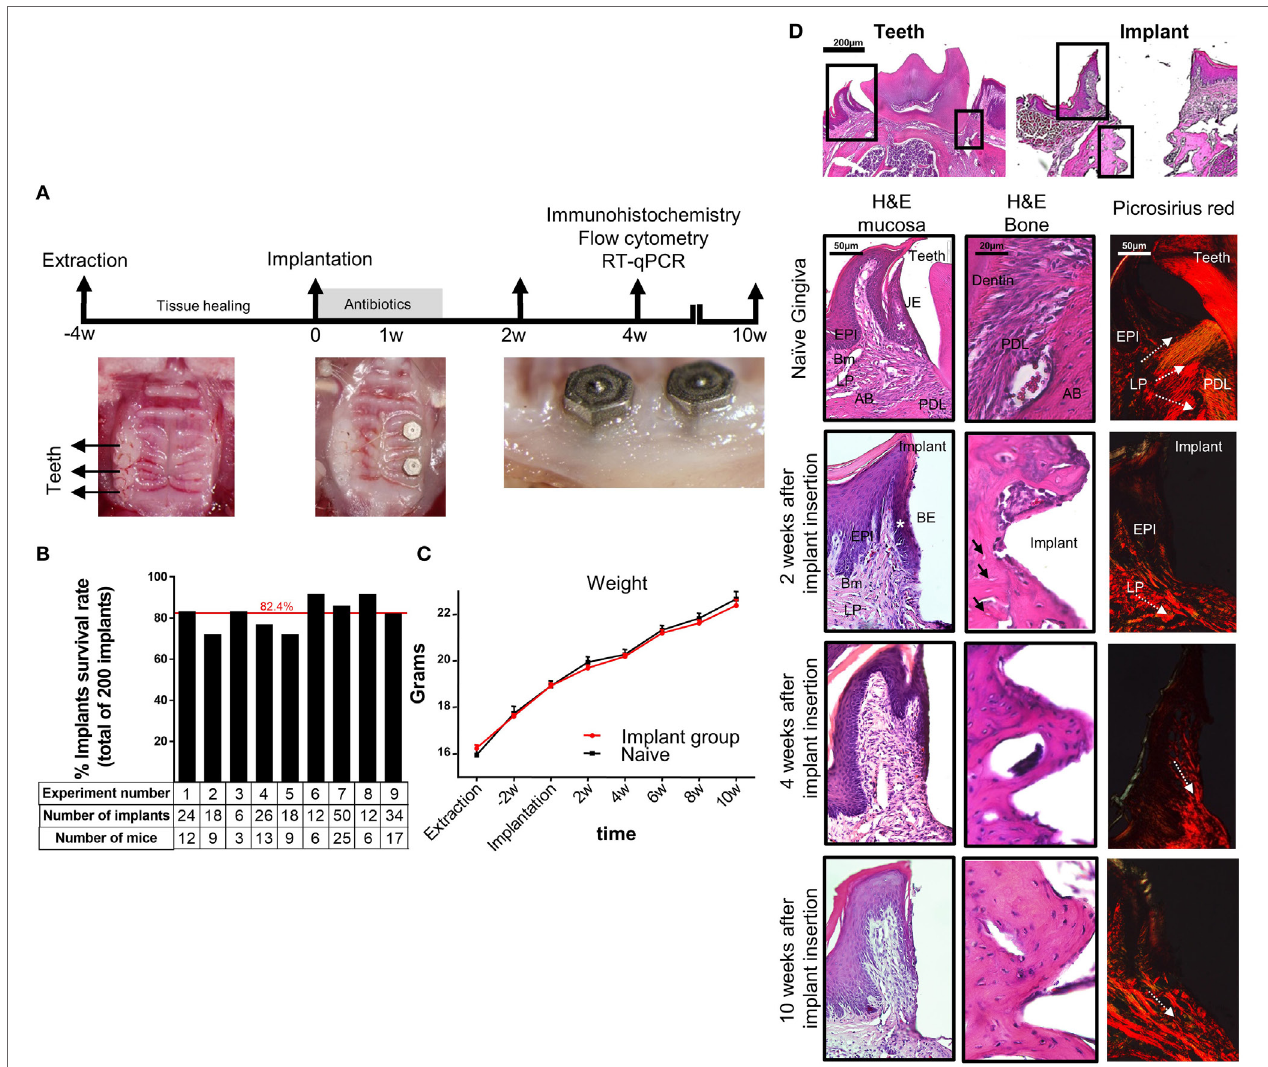
FigUre 1 | Establishment of a murine model of titanium dental implants. (a) Schematic presentation of the experimental setting for insertion of titanium dental implant. Four weeks after tooth extraction two dental implants were inserted in the first and second molar regions of the alveolar bone. The mice were treated for 1 week with antibiotics in the drinking water and soft diet and analyzed 2, 4, and 10 weeks later. (B) Bar graph demonstrates the average cumulative survival rate of both implants in nine independent experiments ( n = 3–25 implanted mice per experiment). The red line indicates the weighted average mean value. (c) Mouse weight in implanted and control mice during 10 weeks post implant insertion, presented as the mean ± SEM ( n = 3–25 mice per group). Representative results of one out of four independent experiments are presented. (D) Images of H&E and Picrosirius red staining of the gingiva, peri-implant mucosa, and bone taken at 2, 4, and 10 weeks after implant insertion. The upper images visualize the orientation of the tissue with respect to the location of interest presented as squares. White asterisk marks the junctional epithelium (JE) around teeth and its equivalent the barrier epithelium (BE) around implants. Black arrows indicate empty osteocyte lacunae. White dotted arrows specify the collagen bundle orientation in the tissues. Representative results of one out of three independent experiments are presented. In each experiment, at least three mice per group were examined. Abbreviations: EPI, epithelium; Bm, basement membrane; LP, lamina propria; PDL, periodontal ligament; AB, alveolar